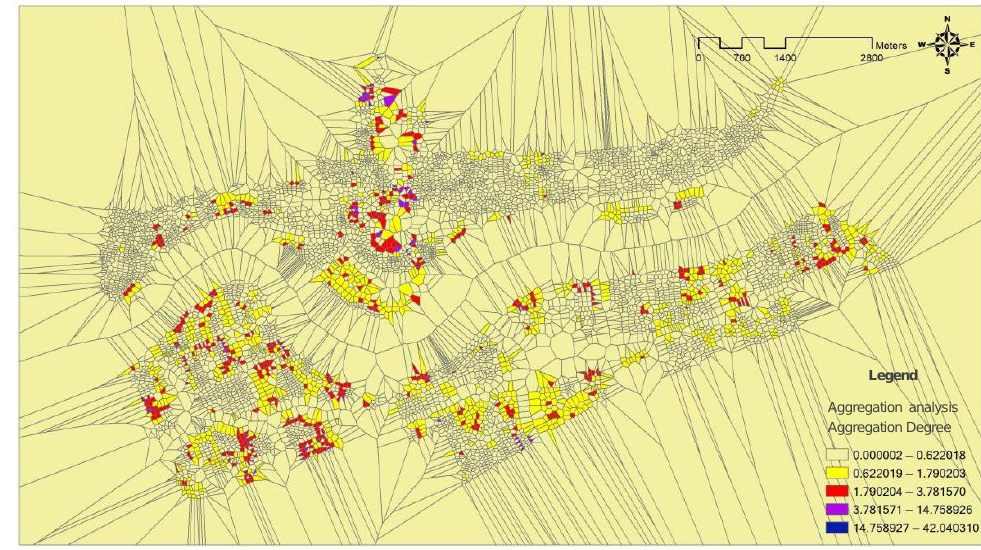
Figure 7. Aggregation degree analysis of fractal morphology on density morphological characteristics of the study area. Source: Authors